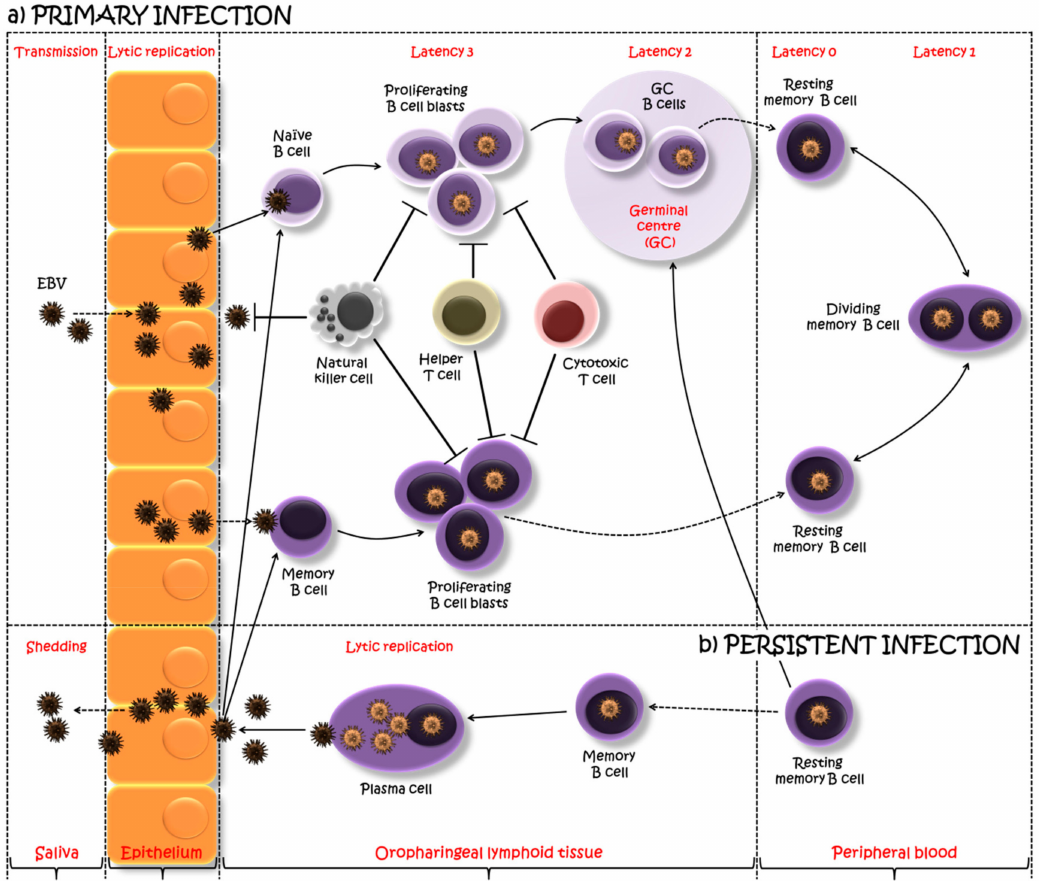
Figure 1. A model of Epstein–Barr virus (EBV) primary and persistent infection. EBV, transmitted via saliva, lytically replicates, possibly in the oropharyngeal epithelium, after which the virus spreads throughout the lymphoid tissues and infects underlying B cells. One viewpoint proposes that EBV infects tonsilar naïve B cells turning them into latently infected proliferating B cell blasts, using the growth program or latency 3, and expressing a full spectrum of latent proteins. The majority of these proliferating cells are removed by natural killer and T cell response. However, the surviving B cell blasts undergo a germinal center (GC) reaction, where a more limited set of viral genes are expressed (the default program or latency 2). The viral persistence is realized through the silent infection of B cells when EBV-infected GC B cells migrate to peripheral blood establishing a stable reservoir of resting memory B cells, in which no EBV gene is expressed (latency program or latency 0). Intermittent expression